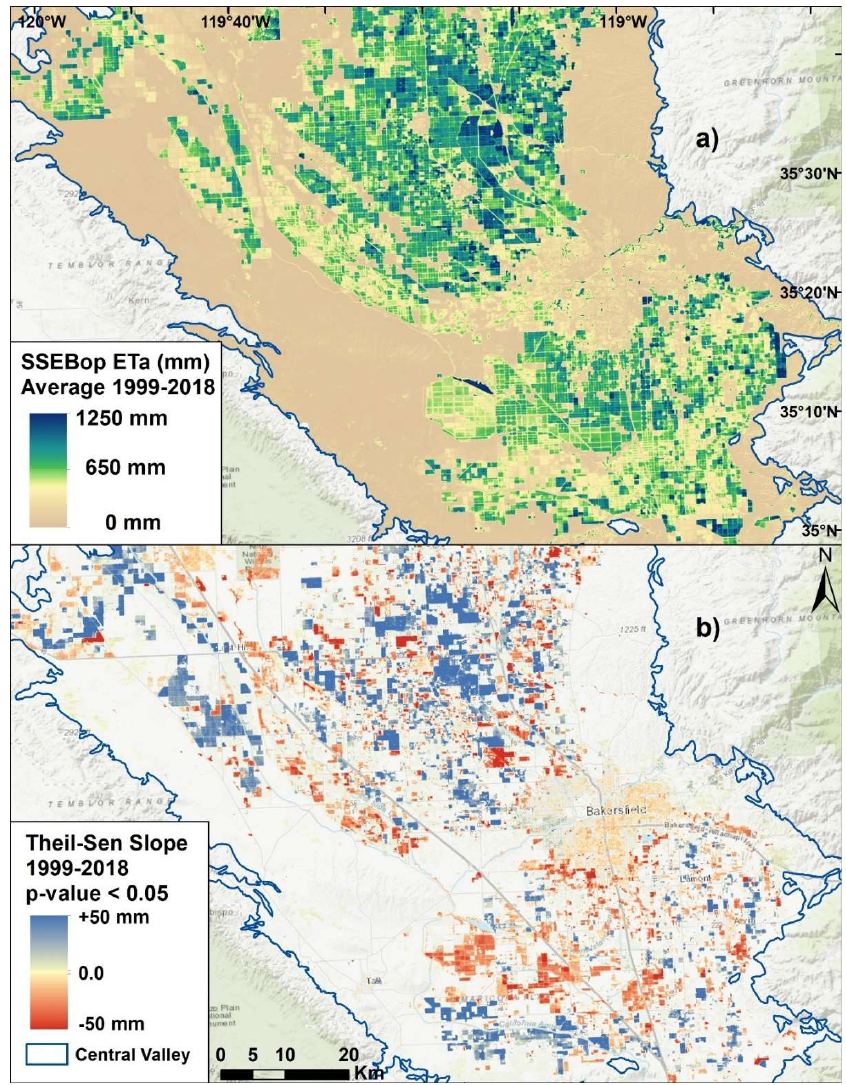
Figure 6. Pixel-based Mann–Kendall trend analysis for all of Kern County based on annual SSEBop ETa from 1999 to 2018. The above graphic shows ( a ) the 20-year (1999–2018) mean annual total SSEBop ETa , ( b ) the Theil–Sen slope statistic on a per-pixel basis for the statistically significant pixels where the MK test p -value < 0.05 (95% confidence).